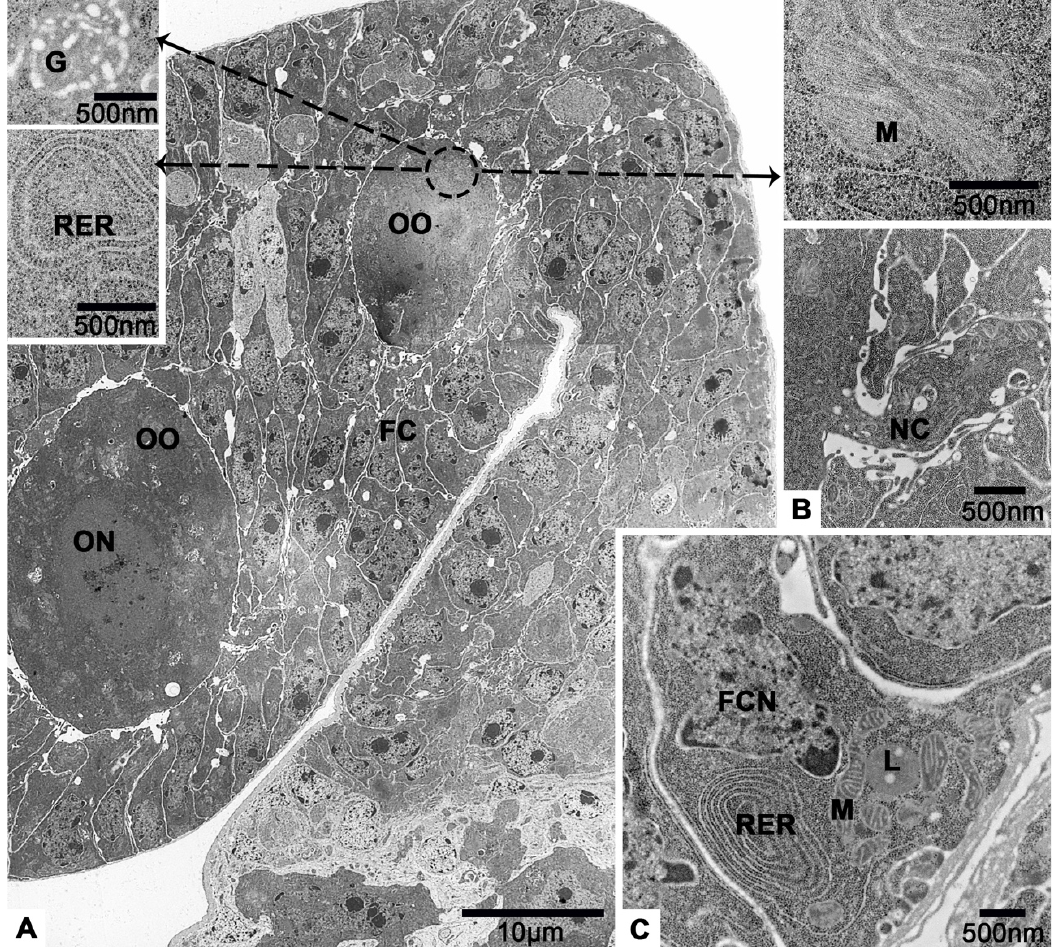
Figure 7. On sixteenth day post-eclosion, the oocytes and follicular cells of T. klimeschi in previtellogenesis. ( A ) The anterior region of vitellarium showing two developing oocytes. The magnified diagrams show the cytoplasmic contents of oocytes. ( B ) The nutritive cord. ( C ) A follicular cell and its cytoplasmic contents. Nucleus of an oocyte (ON); oocyte (OO); follicular cell (FC); Golgi apparatus (G); rough endoplasmic reticulum (RER); mitochondria (M); nutritive cord (NC); nucleus of a follicular cell (FCN); and lysosomes (L).